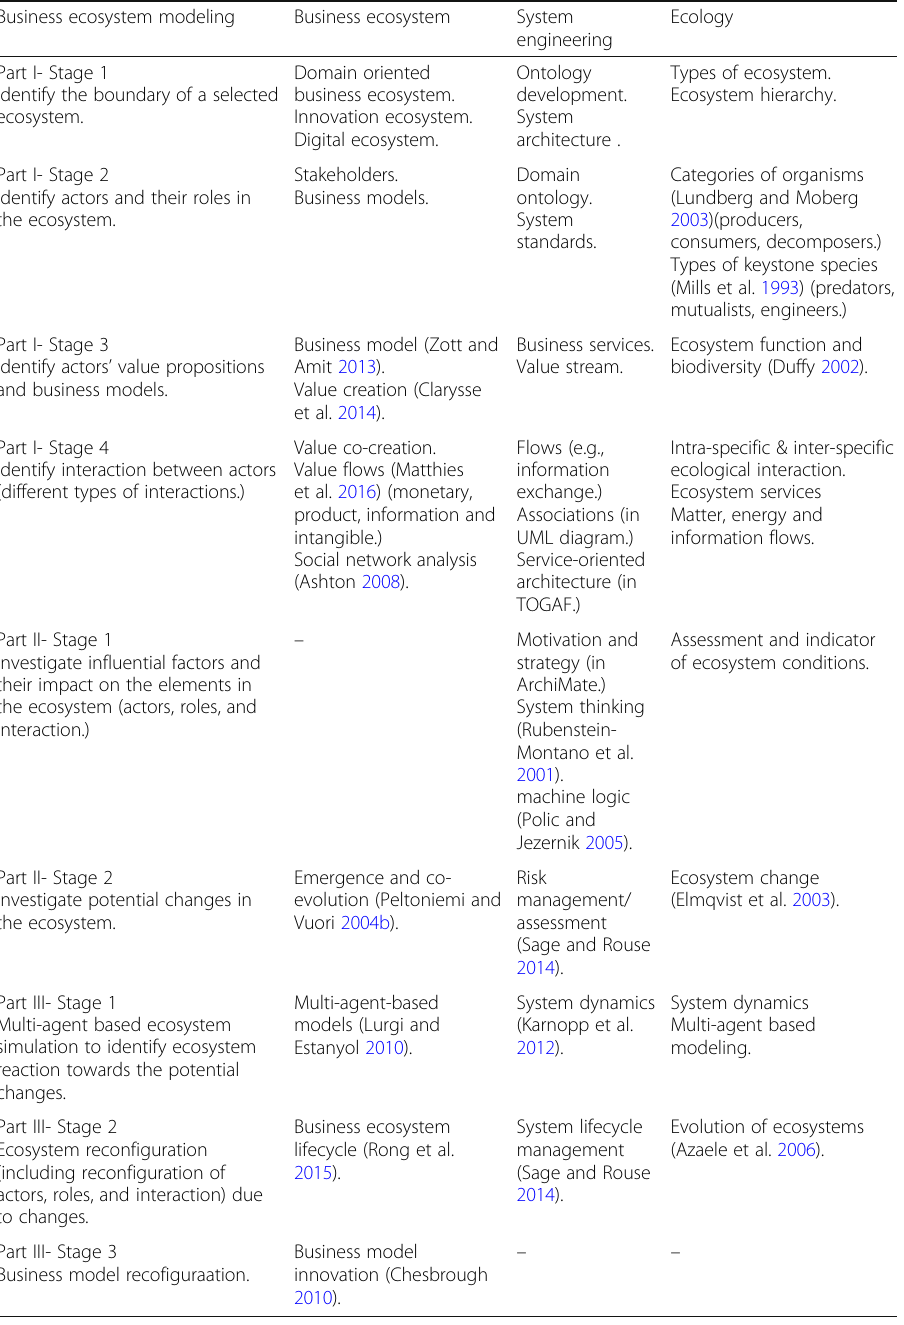
Table 13 The Business Ecosystem Modeling With The Integration of System Modeling and Ecosystem Theory Business ecosystem modeling Part I- Stage 1 Identify the boundary of a selected ecosystem. Part I- Stage 2 Identify actors and their roles in the